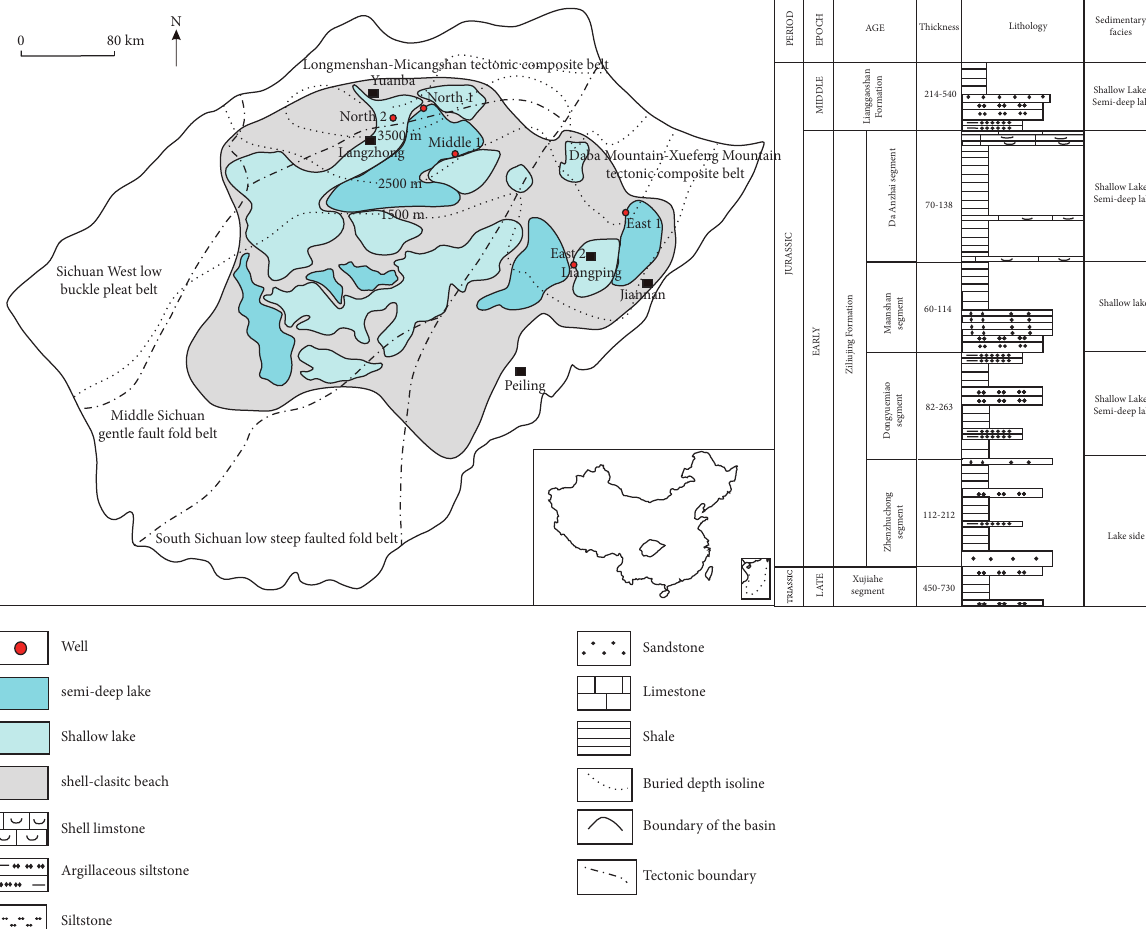
Figure 1: The division of tectonic units in the Sichuan Basin and the shale deposition and distribution characteristics of the Da’anzhai Member of Ziliujing Formation in